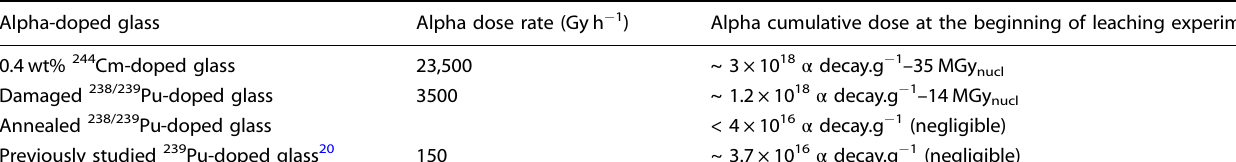
Table 1. Alpha dose rate and cumulative dose values of the doped glasses considered in this